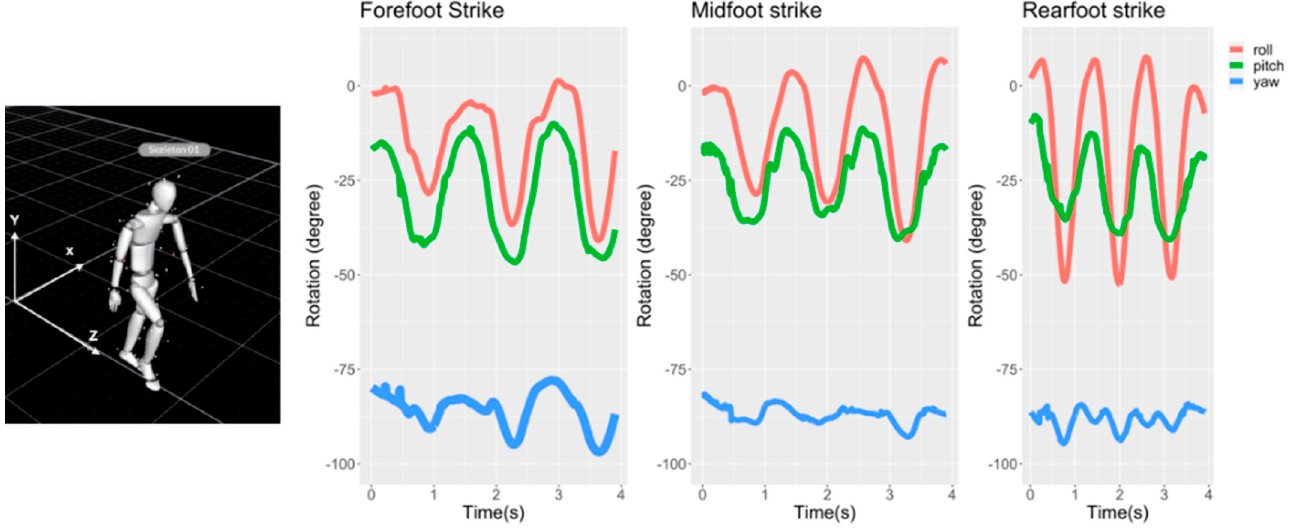
Figure 2. Motion tracking examples while walking with different FS types ( right ). Angular motions (roll, pitch, and yaw) of the ( left ) forearm are displayed.